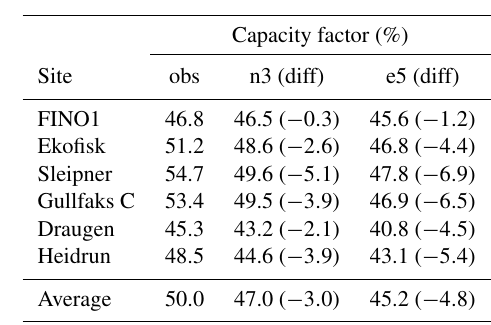
Table 4. Capacity factor (%) calculated from the observations (obs), NORA3 (n3), and ERA5 (e5) for the six sites. In addition, the differ- ences (diff) between NORA3 and observations and between ERA5 and observations are also